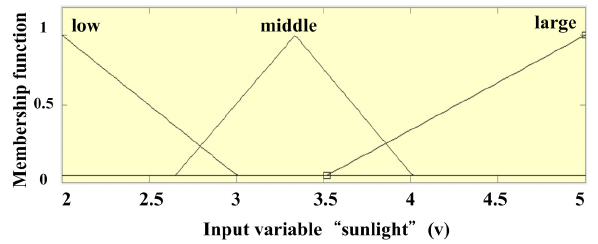
Figure 5. Membership function of sunlight.